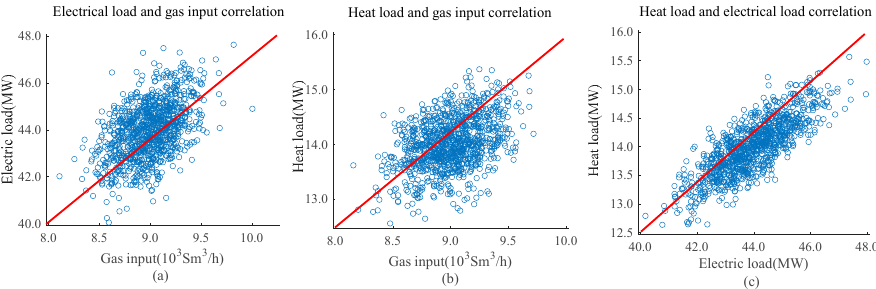
Figure 9. Data samples of correlation between random variables at maximum reference load in 2026: ( a ) associated gas production and electric load; ( b ) associated gas production and heat load; ( c ) heat load and electric load.